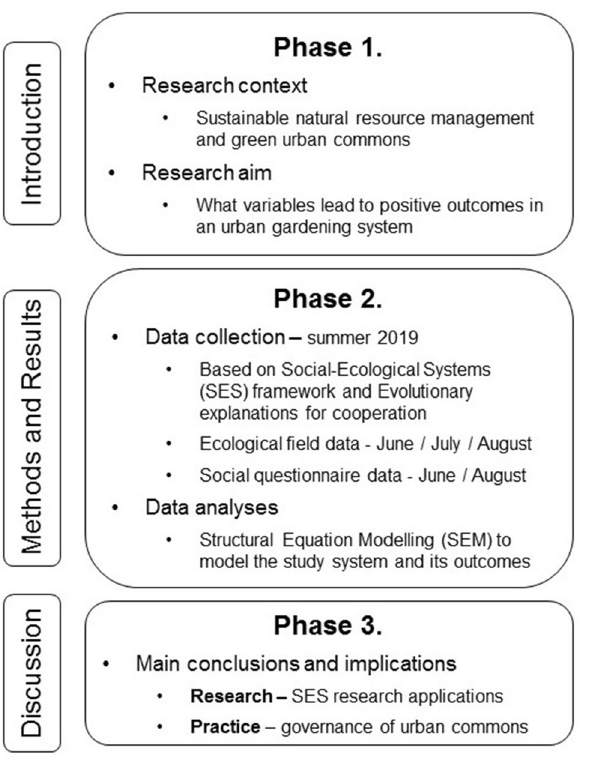
Figure 2. A research flowchart of the